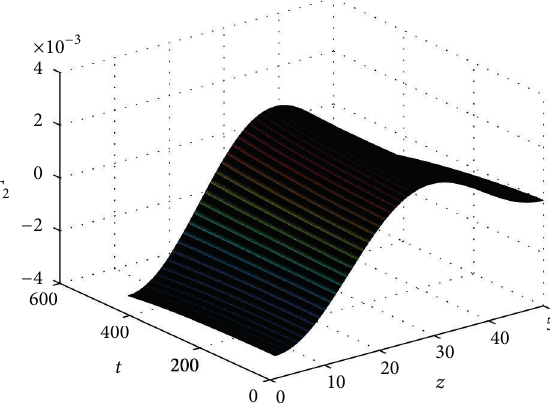
Figure 1: State of the first distributed parameter system. Figure 2: State of the second distributed parameter system.